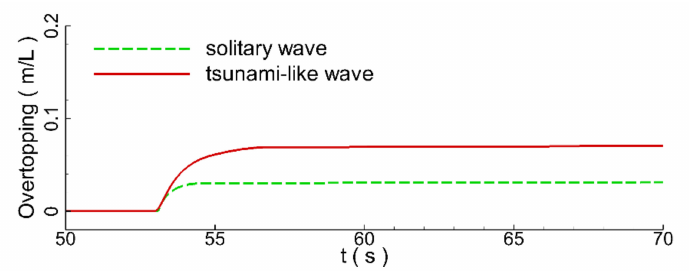
Figure 17. Comparison of the time series of overtopping water volume.